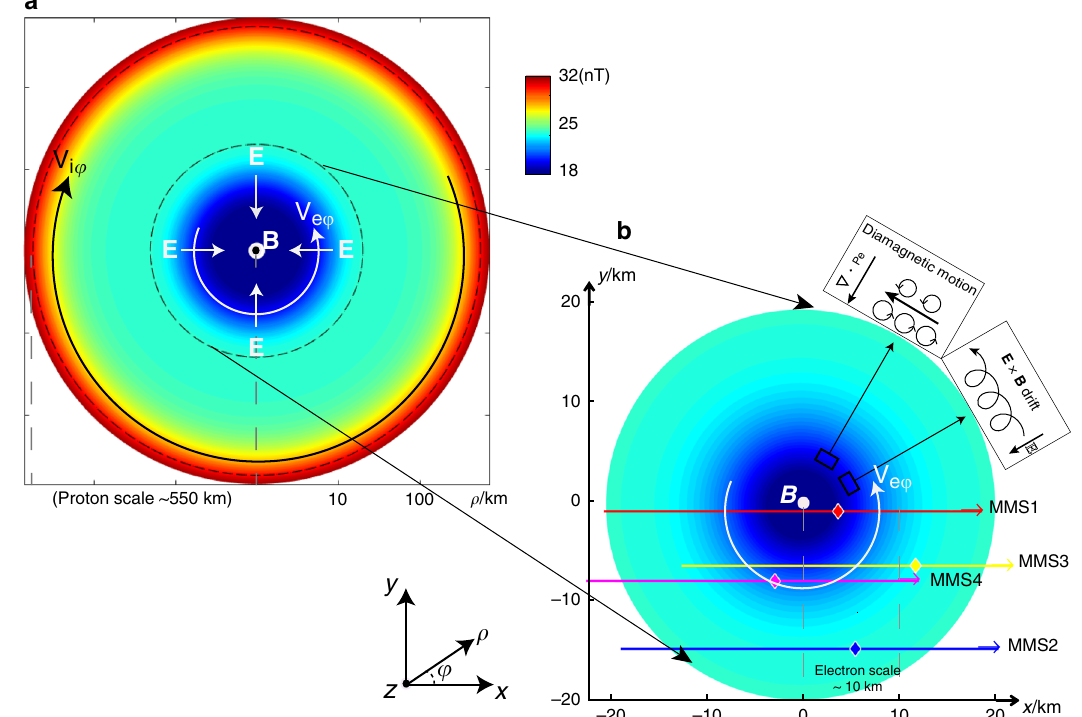
Fig. 2 Cross-section of the nested magnetic cavities in the perpendicular plane. Panel a shows the nested cavities in the proton scale (~550 km, in logarithmic form), and Panel b shows the zoomed-in view within the electron scale (~10 km, in linear form). The color denotes the magnetic fi eld strength pro fi les. The four lines are the trajectories of the MMS constellation across the nested cavities, with the diamond symbols representing their positions within the modeled cavities at 14:59:34.21 UT. The de fi nition of the Cartesian ( x , y , z ) and the cylindrical ( ρ , φ , z ) coordinates are given in the bottom-left corner. The directions of the electric fi eld, proton and electron bulk velocities are also indicated as arrows in the plots. The two insets in panel b illustrate the nature of the electron diamagnetic motion and their E × B drift,